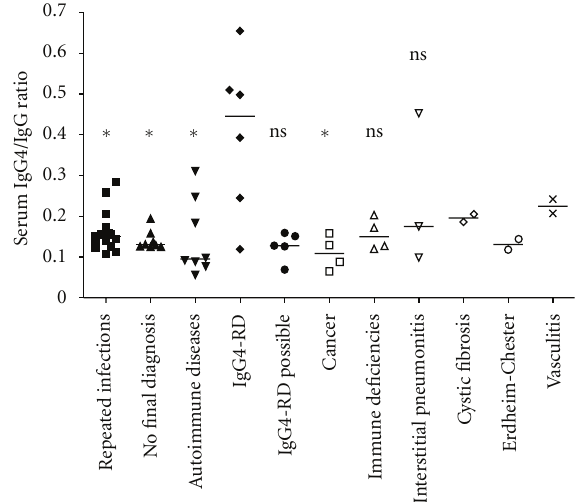
Figure 2: Serum IgG4/serum IgG ratios in di ff erent final diagnostic categories of patients with serum IgG4 elevation. IgG4-RD = IgG4- related disease. Horizontal bars represent median values observed in each group. Results obtained in each group were compared to results obtained in IgG4-RD group (Mann-Whitney test): ∗ P < 0 . 05; ns: not